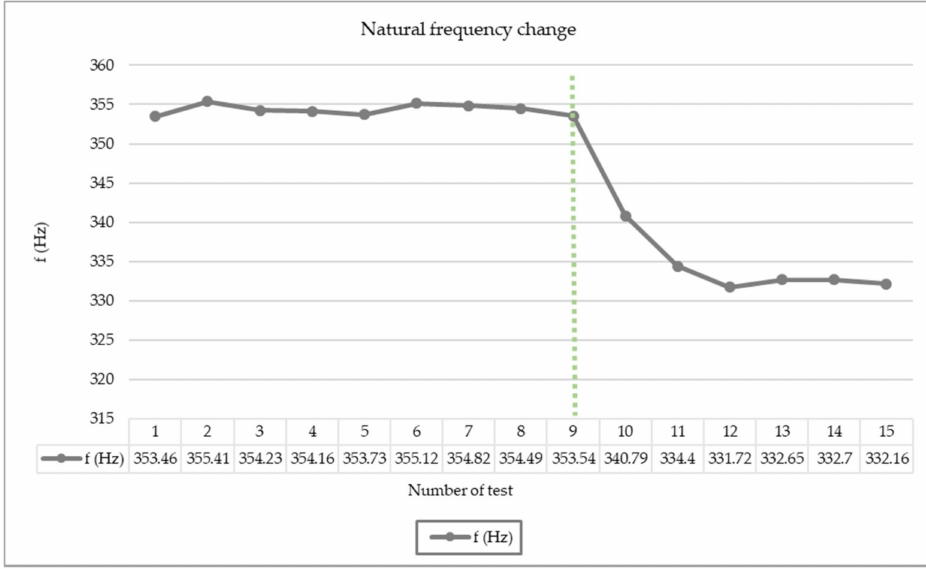
Figure 8. Change in the natural frequency values after a single test (author’s processing based on